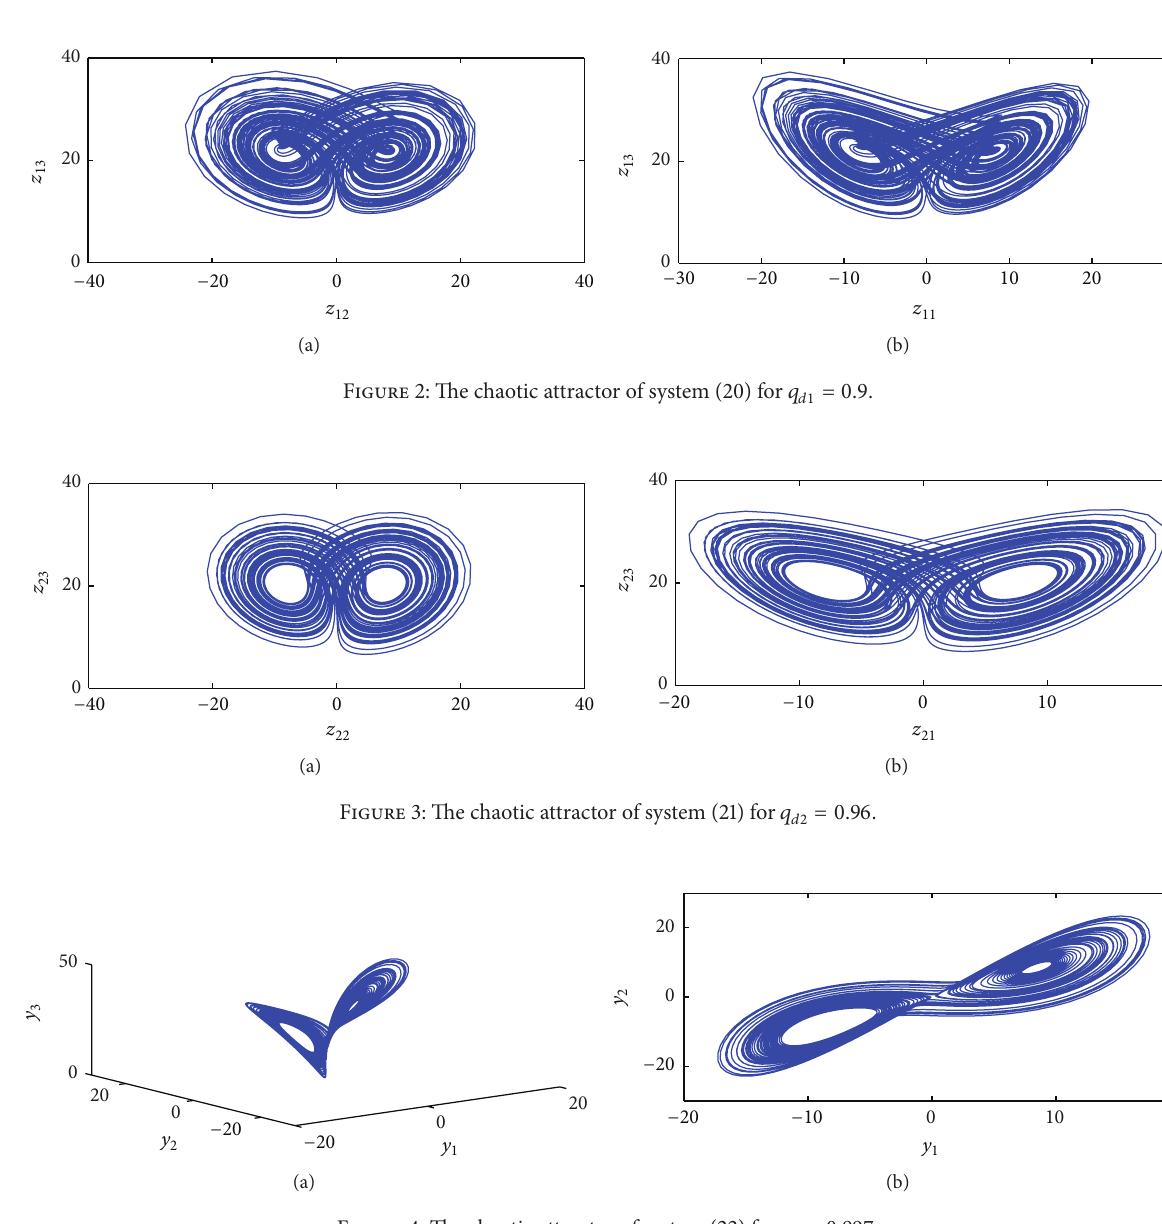
Figure 4: The chaotic attractor of system (22) for 𝑞 𝑟 = 0.997